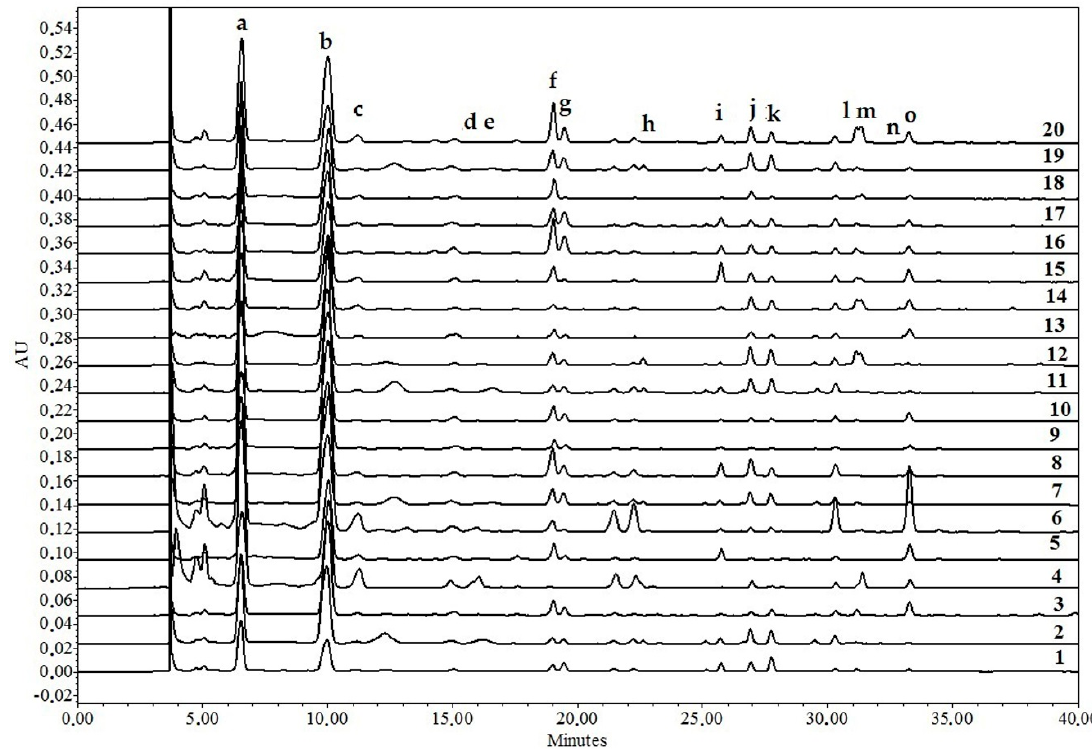
Figure 1. Phenolic compound profiles of different Sorbus fruit powder samples. a—neochlorogenic